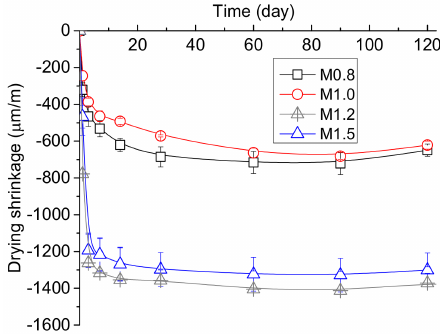
Figure 12. Drying shrinkage of the geopolymer coating.